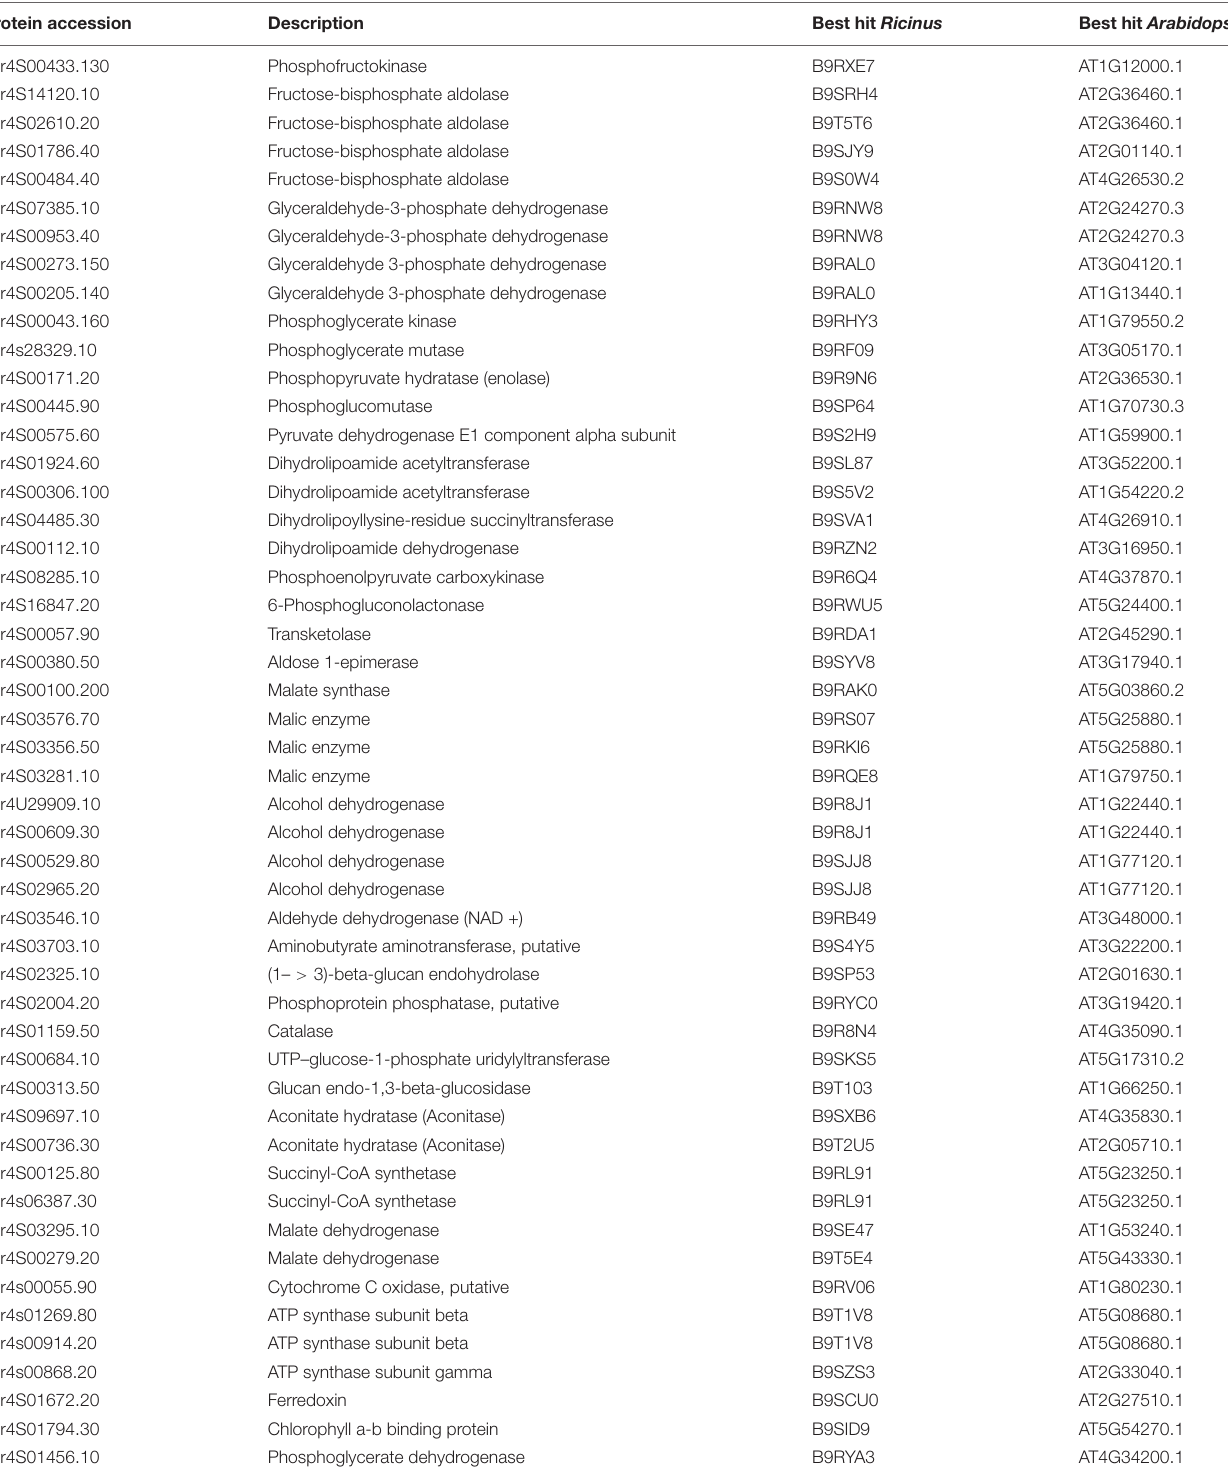
TABLE 2 | Proteins related to carbohydrate metabolism identified from the embryo of mature J. curcas seeds. Protein accession